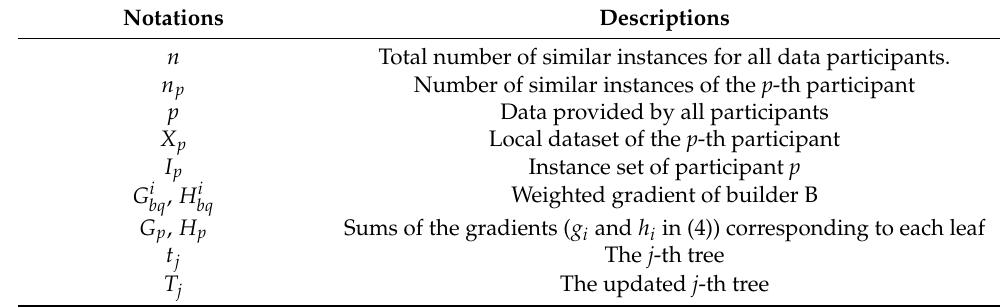
Table 1. Mathematical notations of